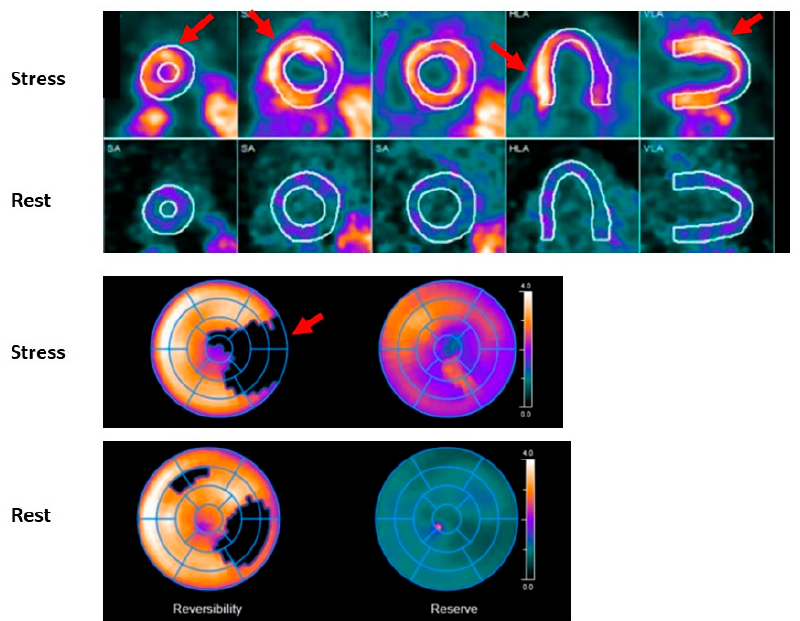
Figure 3. shows a regadenoson myocardial perfusion PET study. A large, mostly fixed, defect of severe intensity involving the entire inferolateral wall and basal anterolateral wall, as well as the apex is visible (red arrows). Minimal reversibility was noted in the apical lateral wall.